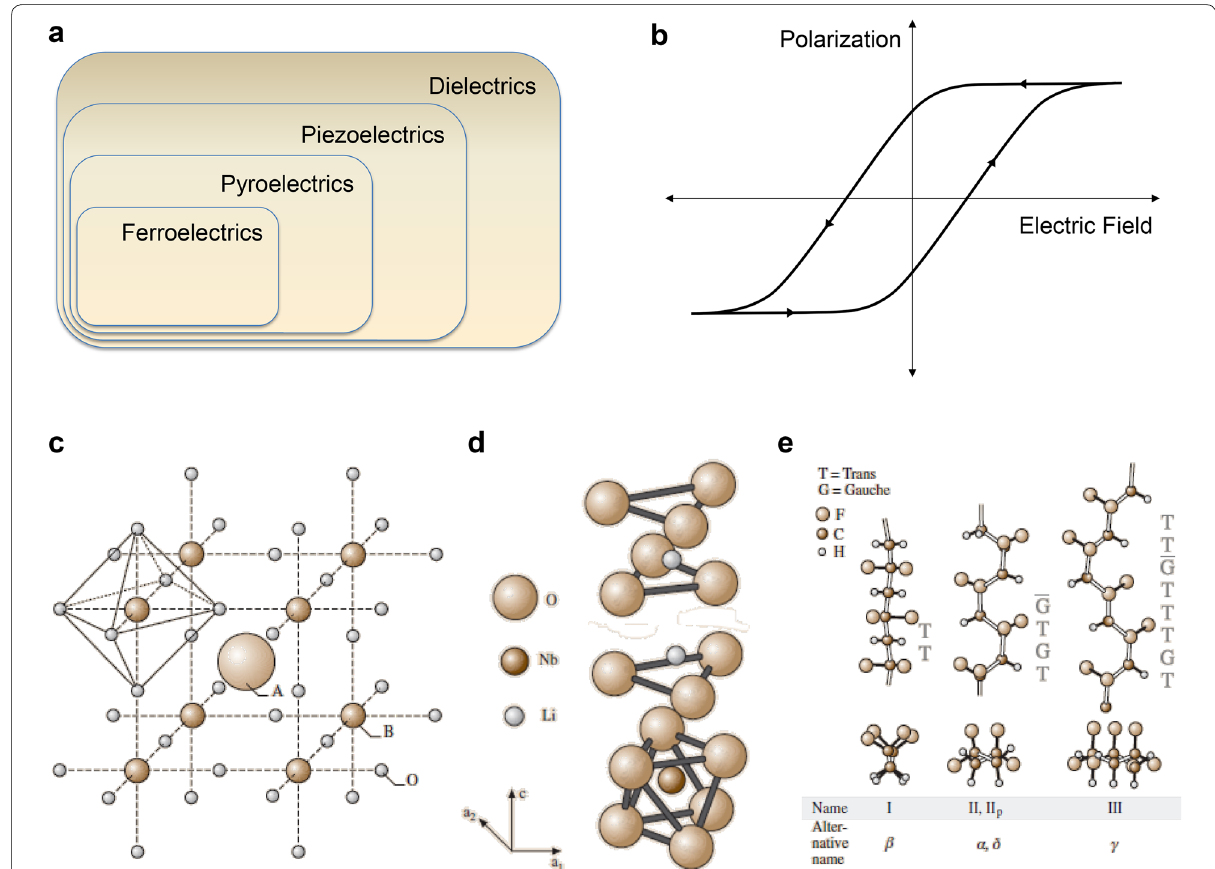
Fig. 1 a Ferroelectrics in Venn diagram of dielectric classes. b Hysteresis loop of ferroelectric material in P–E curve. c Crystal structure of perovskite d ilmenite, and e polymeric ferroelectric material (Reproduced from [5] with copyright permission from 2006